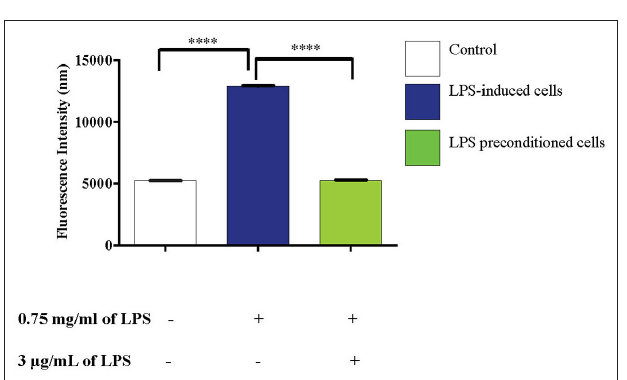
FIGURE 16 | LPS activates pro-inflammatory mediators, NO. The release of NO in LPS-induced and LPS-preconditioned cells were measured using Griess assay. Bars represent mean data ± S.E.M from three independent experiments. Data were analyzed using one-way ANOVA, followed by a Bonferroni post-hoc test. Relative release of nitrite in LPS-induced cells were compared to the control. **** p < 0.0001 considered to be statistically